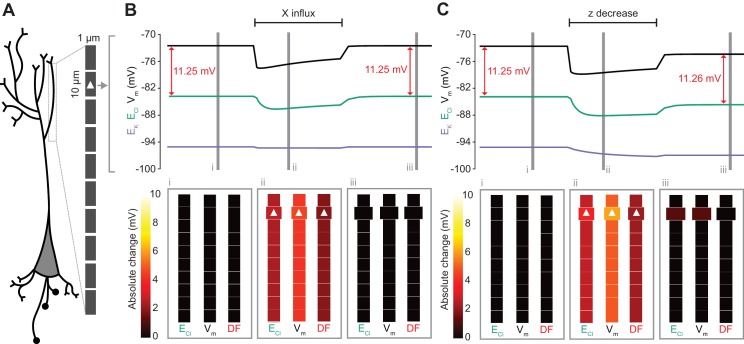
Local changes in impermeant anions do not establish the local driving force for chloride.(A) Multi-compartment model of a 10 compartment 100 μm virtual dendrite as in Figure 7. (B) Top panel, ECl (green), EK (purple), Vm (black) and DF (arrows, red) within the compartment where additional impermeant anions were exclusively added (indicated with a white triangle). The insets depict the diameter, and absolute change from baseline for ECl, Vm and DF for each compartment of the virtual dendrite before (i), during (ii) and after (iii) impermeant anions were added. The selective addition of impermeant anions of default charge (z = −0.85) to the 2nd from top compartment resulted in transient but non-permanent shifts in ECl, Vm and the Cl- DF in all compartments. The volume of the compartment where impermeant anion addition occurred increased permanently. (C) Traces and insets as in ‘B’ showing the addition of impermeant anions of more negative charge in order to decrease z in the second from top compartment specifically. Note that during addition of impermeant anions, ECl, EK, Vm changed. We also observed persistent decreases in ECl and Vm in the compartment manipulated, with a negligible change in DF (0.01 mV). Again, impermeant anion addition resulted in an increase in the volume of the specific dendritic compartment manipulated.